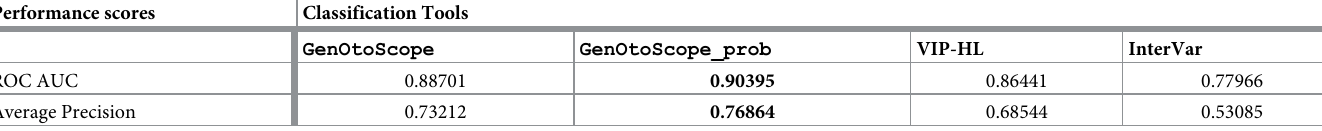
Table 3. Micro-averaged performance scores for all classification tools, over the three broader classes in the MHH data set. Best values of a performance score, across all classification tools, are shown in bold. Performance